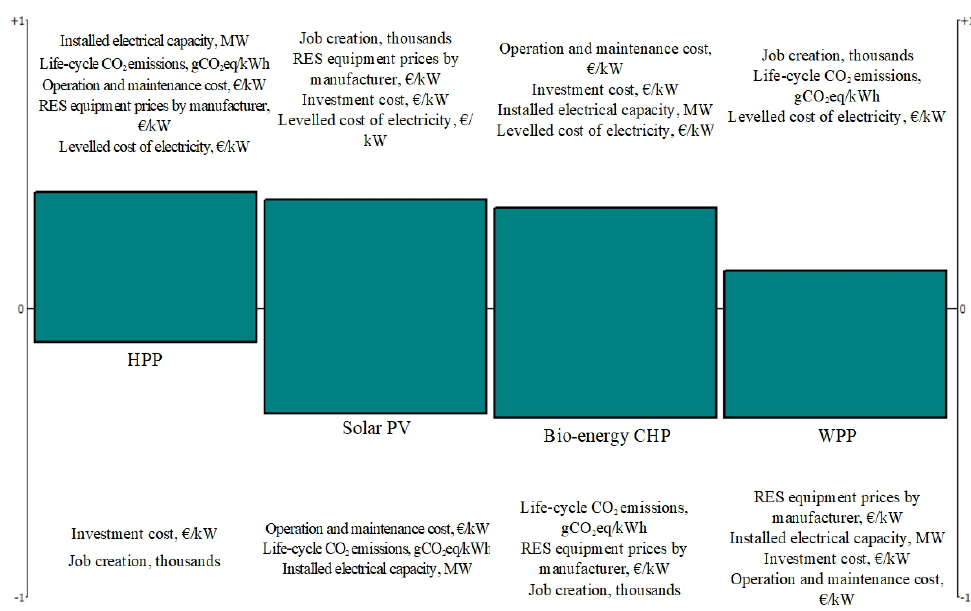
Fig. 3. PROMETHEE